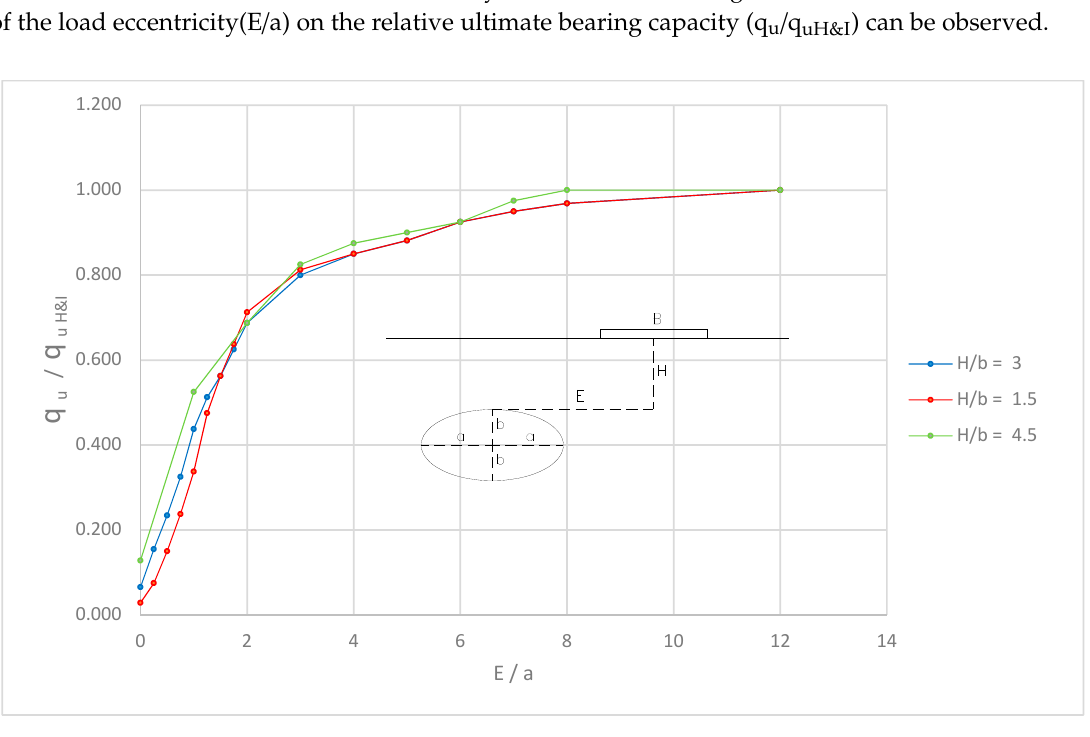
Figure 6. Case IEH-2. Eccentricity E/a = 12 ( classic plastic failure mechanism, with formation of complete yield wedges on both sides of the footing. Minimum influence of the cavern).